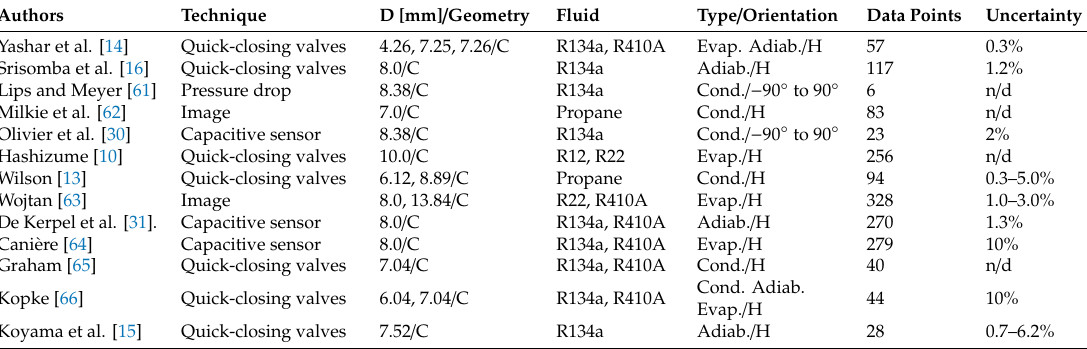
Table 4. Database for void fraction for macrochannel.